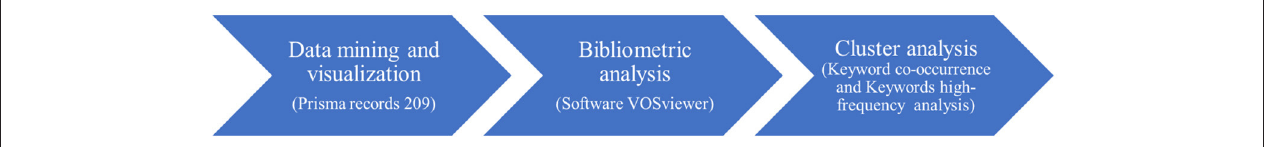
FIGURE 2 | VOSViewer procedure (Source: our elaboration).